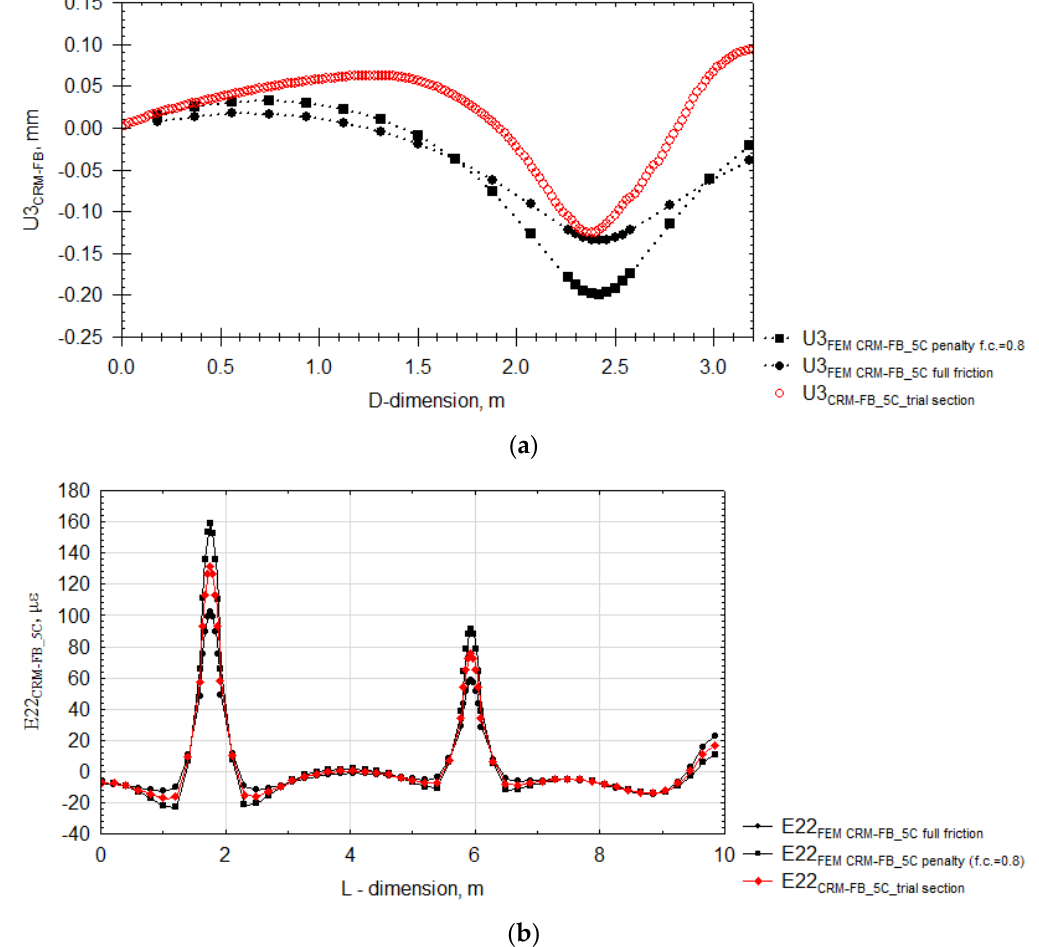
Figure 13. Changes in strain and displacement under the CRM-FB_5C recycled base after 1200 s: ( a ) vertical displacement U3 versus D dimension; ( b ) strain E22 versus L-dimension.